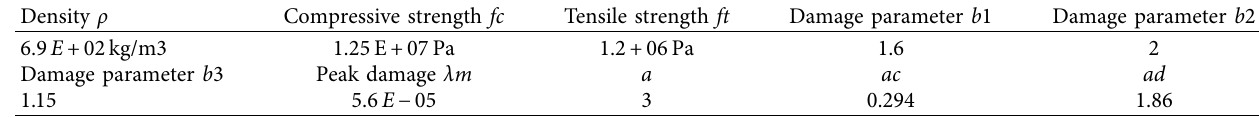
Table 1: Modified K&C model parameters (unit: N, m, Pa, s).